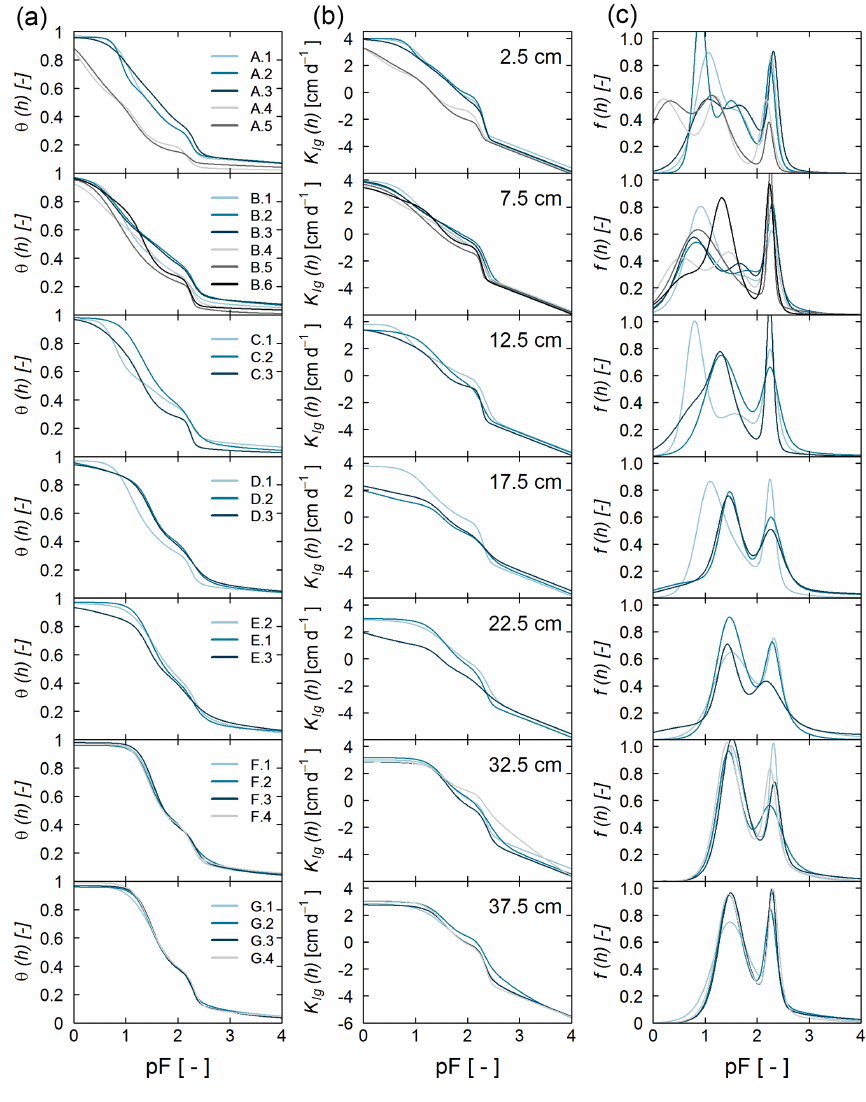
Figure 4. Left panels: water retention curves; centre panels: hydraulic conductivity curves; and right panels: pore-size distributions (of all 28 samples, K lg refers to the common logarithm of the conductivity value).